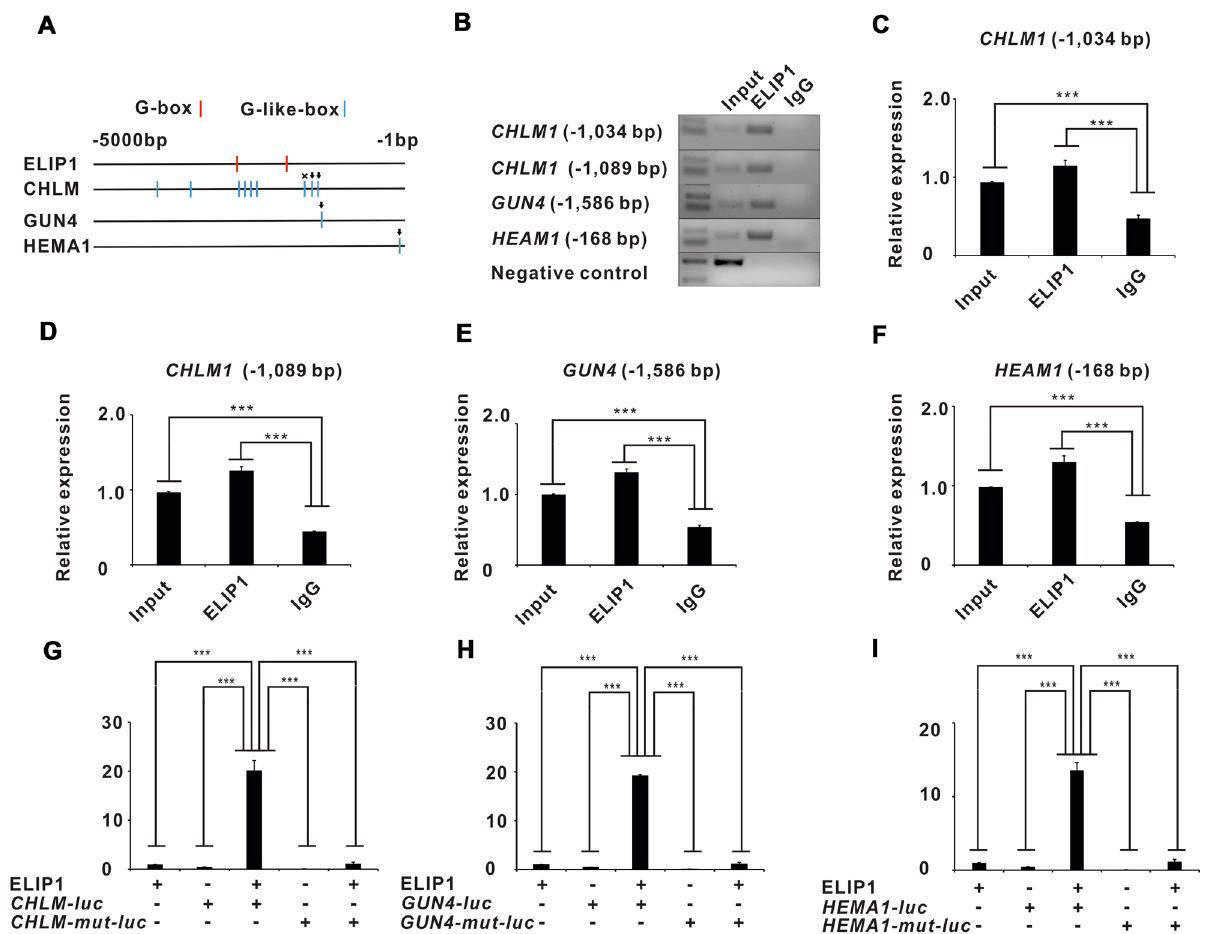
Figure 4. ELIP1 regulates CHLM , GUN4 , and HEMA1 via the G-box-like motifs. ( A ) Sketch map of G-box (in red) and G-box-like motifs (in blue) in gens promoter. The ELIP1-binding G-box-like motifs were marked with black arrows, and the non-ELIP1-binding G-box-like motifs were marked with the “×” symbol. ( B ) Gel electrophoresis of ChIP assays. ( C ) Higher binding strength of ELIP1 at the site of CHLM (− 1034) than Input and IgG. The binding strength was the ratio of ChIP signal to the normalized Input signal. ( D ) Higher binding strength of ELIP1 at the site of CHLM (− 1089) than Input and IgG. The binding strength was the ratio of ChIP signal to the normalized Input signal. ( E ) Higher binding strength of ELIP1 at the site of GUN4 (− 1586) than Input and IgG. The binding strength was the ratio of ChIP signal to the normalized Input signal. ( F ) Higher binding strength of ELIP1 at the site of HEMA1 (− 168) than Input and IgG. The binding strength was the ratio of ChIP signal to the normalized Input signal. ( G ) Luciferase reporter assays showed that C HLM was directly regulated by ELIP1 through G-box-like motifs, but luciferase activities were inhibited when the binding sites were mutated. ( H ) Luciferase reporter assays showed that HEMA1 was directly regulated by ELIP1 through G-box-like motifs, but luciferase activities were inhibited when the binding site was mutated. ( I ) Luciferase reporter assays showed that GUN4 was directly regulated by ELIP1 through G-box-like motifs, but luciferase activities were inhibited when the binding site was mutated. Asterisks indicate a significant difference compared to control negative as analyzed by Dunnett, one-way ANOVA. (* p < 0.05; ** p < 0.01; *** p < 0.001). All error bars are expressed as